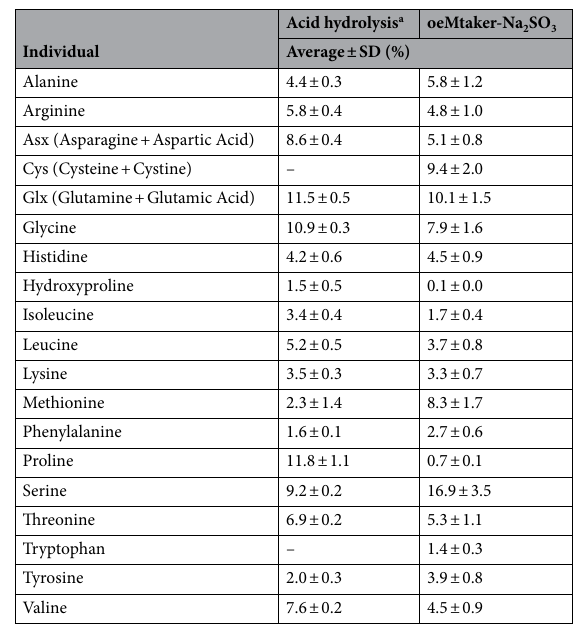
Table 1. The composition of amino acids in ESM hydrolysate (ESM-EH). –, Not detected; a Data was averaged from amino acid composition of inner shell membrane and outer shell membrane which decomposed by acid hydrolysis 35 , which used acid hydrolysis method to decompose